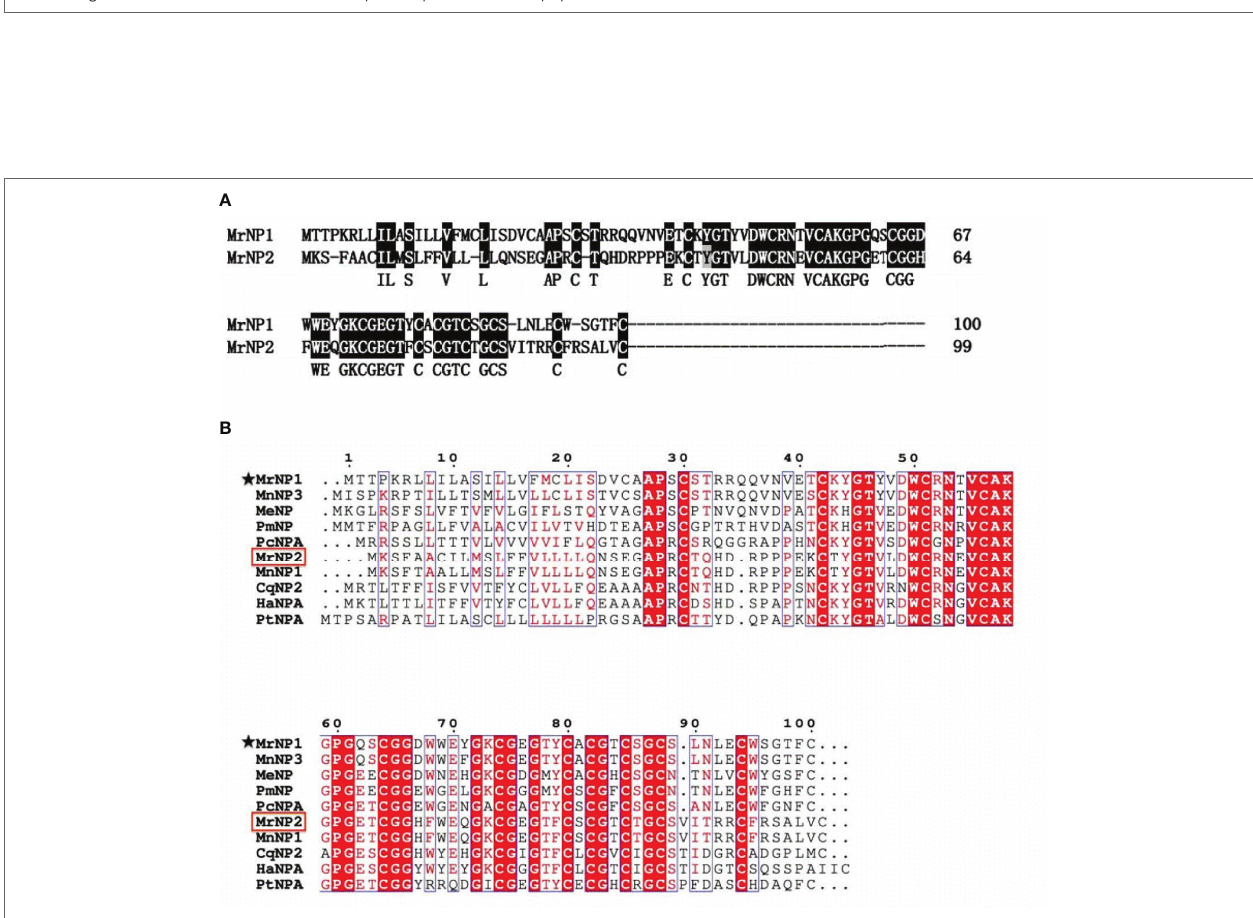
FIGURE 2 | (A) Alignment of MrNP1 and MrNP2. (B) Multiple-sequence alignment of selected neuroparsins from different arthropods including the insects and crustaceans. These sequences are as follows: M. nipponense NP3 (GenBank# QBG05398.1); Metapenaeus ensis NP (GenBank# AHX39208.1); Penaeus monodon NP (GenBank# ALO17555.1); Procambarus clarkii NPA (GenBank# XP_045591875.1); Macrobrachium nipponense NP1 (GenBank# QBG05396.1); Culex quinquefasciatus NP2 (GenBank# AWK57531); Homarus americanus NPA (GenBank# XP042239197.1); Portunus trituberculatus NPA (GenBank# XP045122305.1). M. rosenbergii neuroparsin 1 and neuroparsin 2 (MrNP1, MrNP2) were marked with an asterisk and a box,